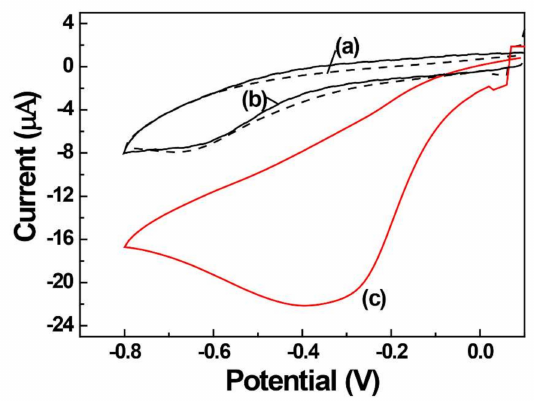
Figure 4. Cyclic voltammograms of ( a ) bare, ( b ) PEI-coated, and ( c ) AgNPs / PEI-decorated